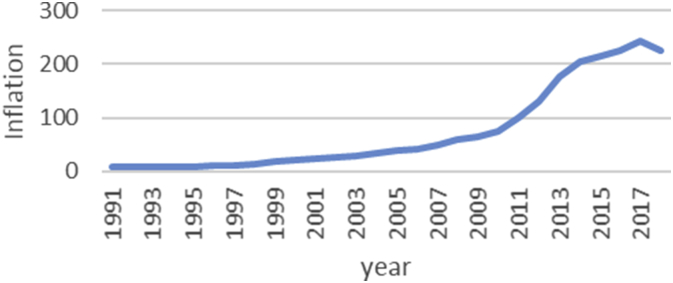
Graph inflation.